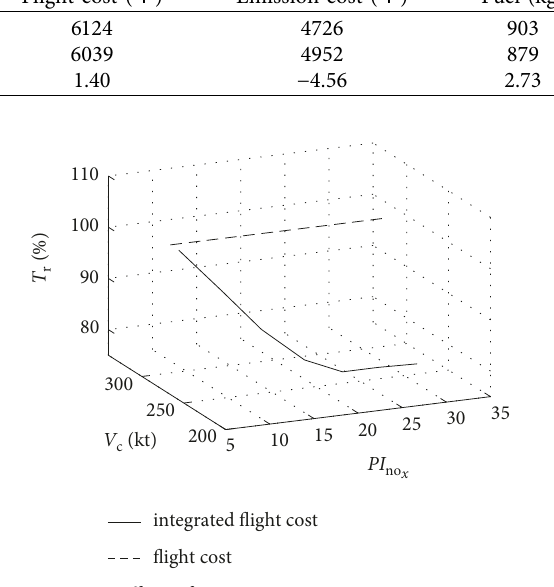
Figure 9: Effect of PI on optimization NO X